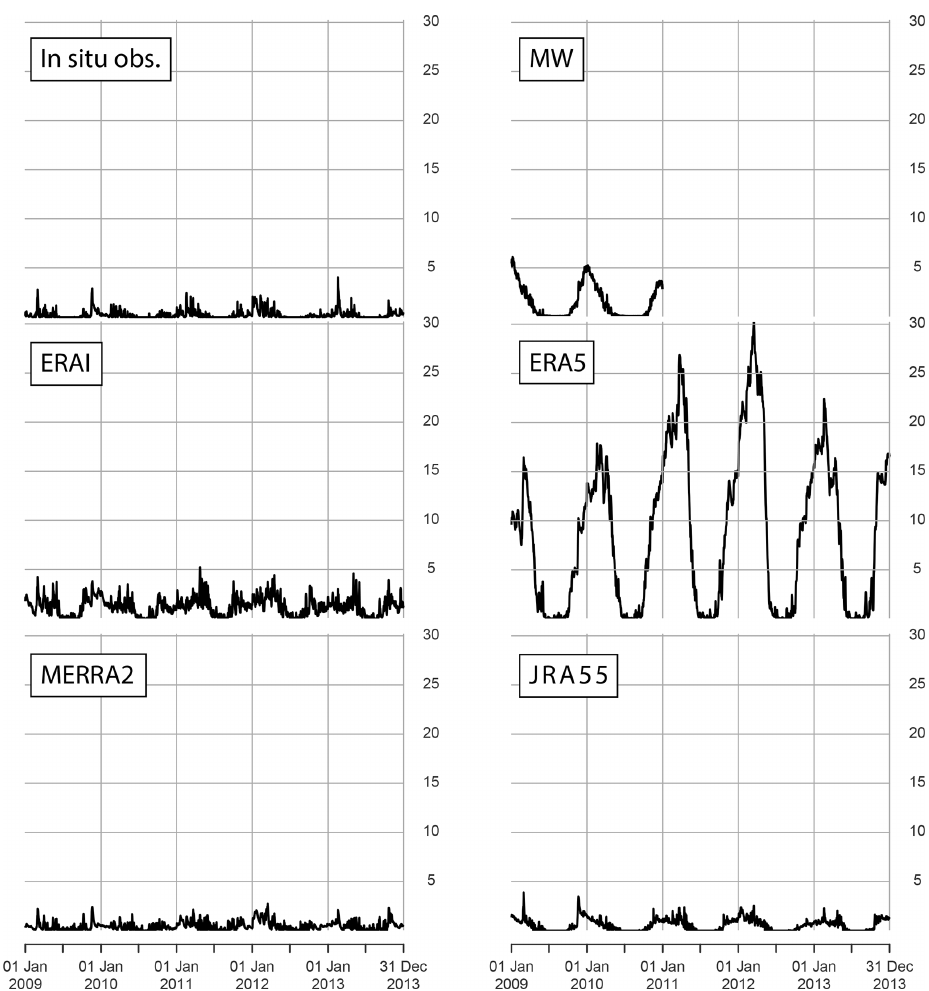
Figure 2. Comparison over the 5-year period 2009–2013 of daily SD (in centimetres) between the observations, comprising both in situ station and MW data (over 2009 and 2010), and the four reanalyses collocated at the station coordinates, namely ERA5, ERA-I, MERRA-2 and JRA-55. The average is carried out over the 33 stations shown in Fig.